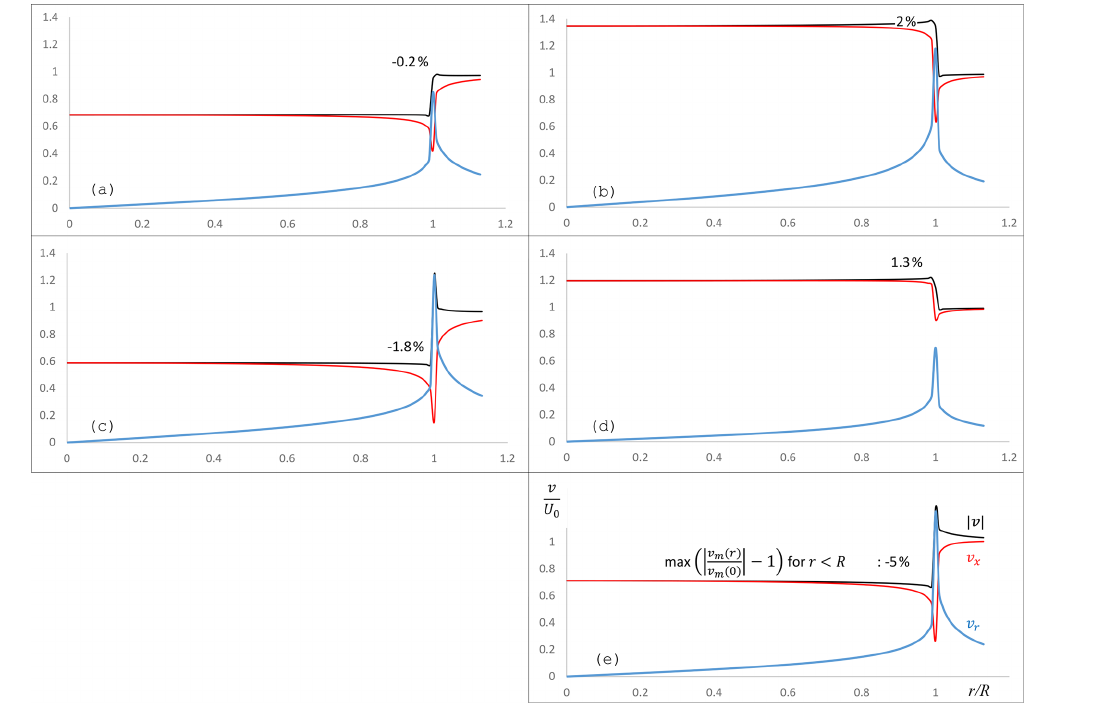
(cid:113) v 2 x + v 2 r /U 0 ; red line: u =